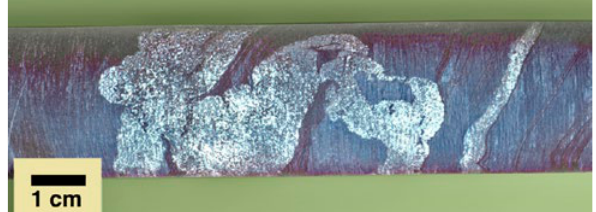
Figure 33. A ptygmatic-type clastic mud dyke or “dirty early quartz vein” was intruded into diagenetic soft and banded hematite shales. These early “out wellings” of entrapped fluid through fine oozy sedi- ment are episodic with each successive reactivation becoming more quartz rich until the filling material resembles vein quartz. (From Explorer 8 drill core, Tennant Creek,